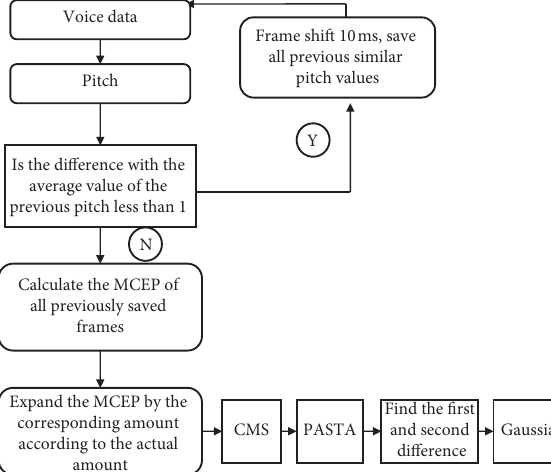
Figure 1: Pitch classification and recognition